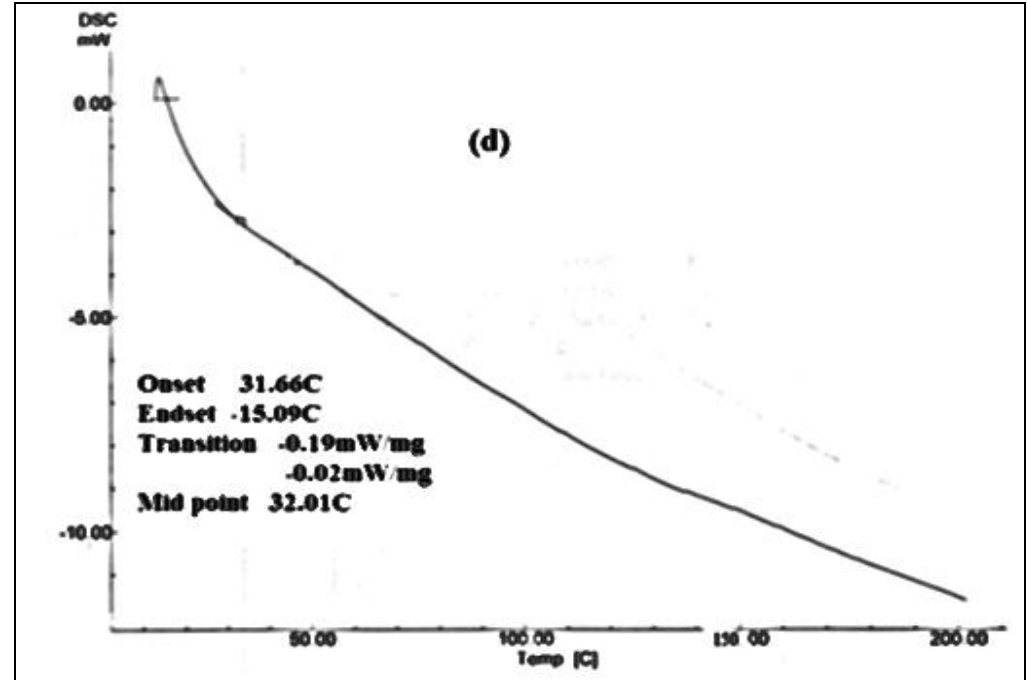
Fig.21: (Temperature glass transition) curves for UP/ nano SiO